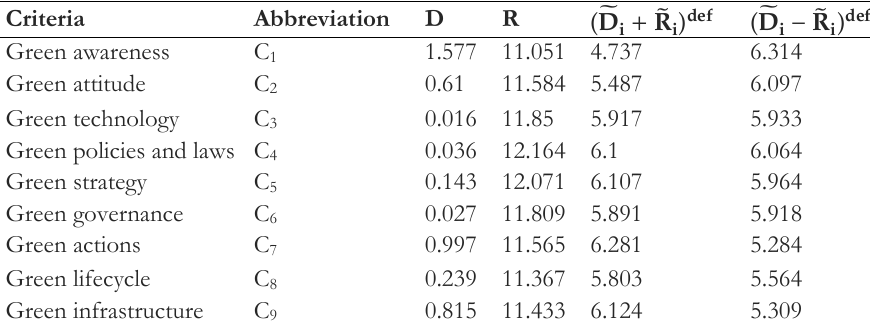
Table 7. The weight & impact of criteria.